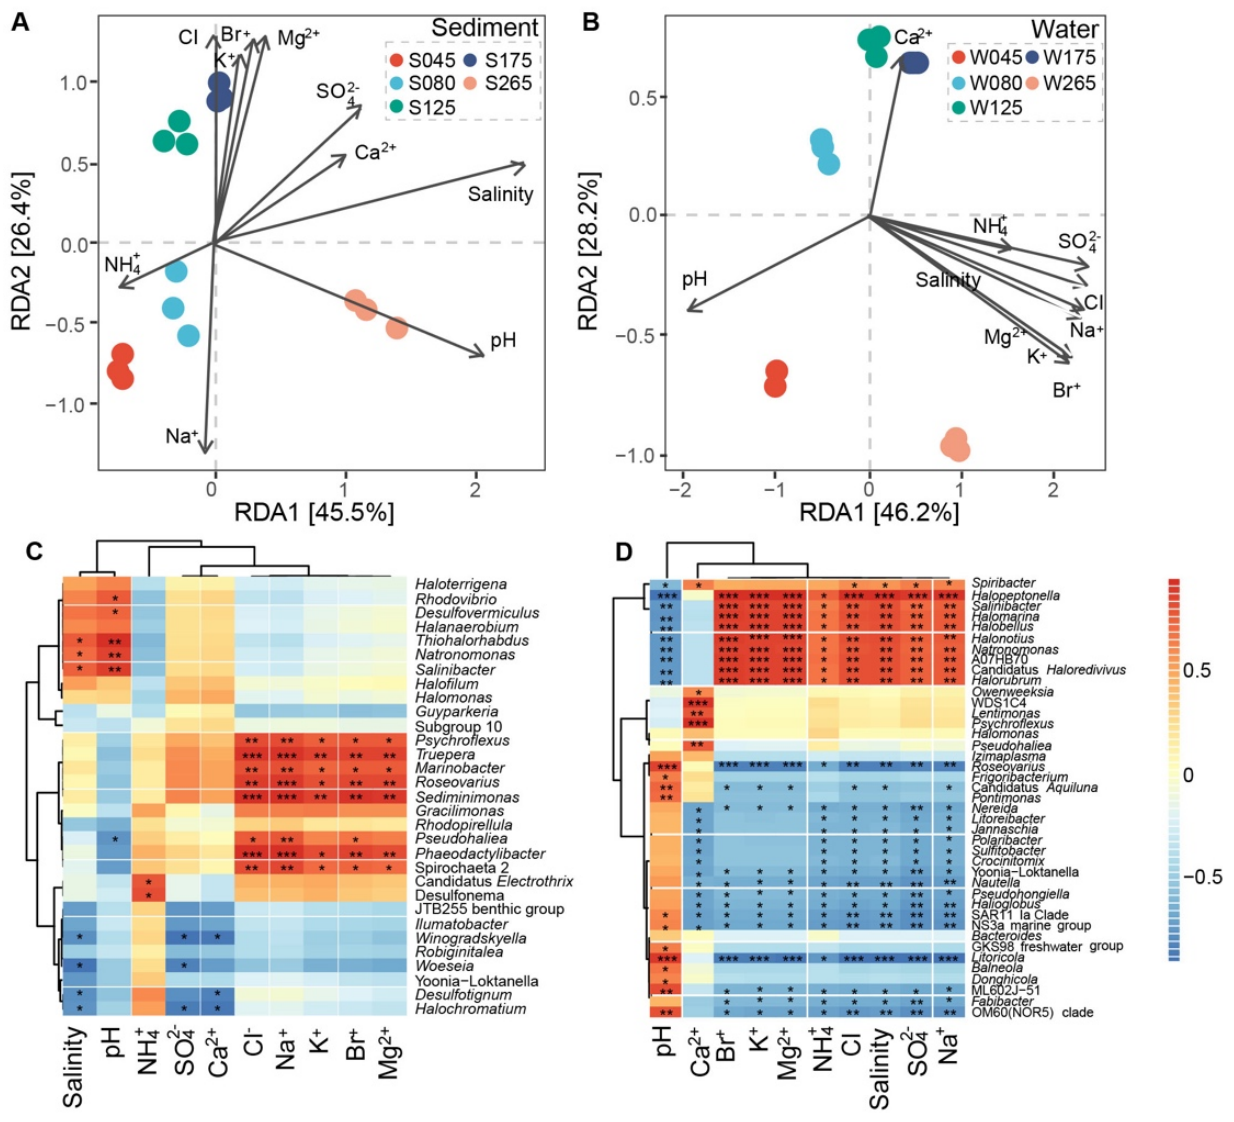
Figure 4. Relationships between physicochemical factors and prokaryotic community composition. ( A , B ), Redundancy analysis (RDA) between prokaryotic community bray-distance and physicochemical factors was employed for both sediment and water samples of the salterns. ( C , D ), The genera strongly related to physicochemical factors are shown; ( C ), sediment groups; ( D ), water groups. Significant differences are marked. (* 0.01 < p ≤ 0.05, ** 0.001 < p ≤ 0.01, *** p ≤ 0.001).